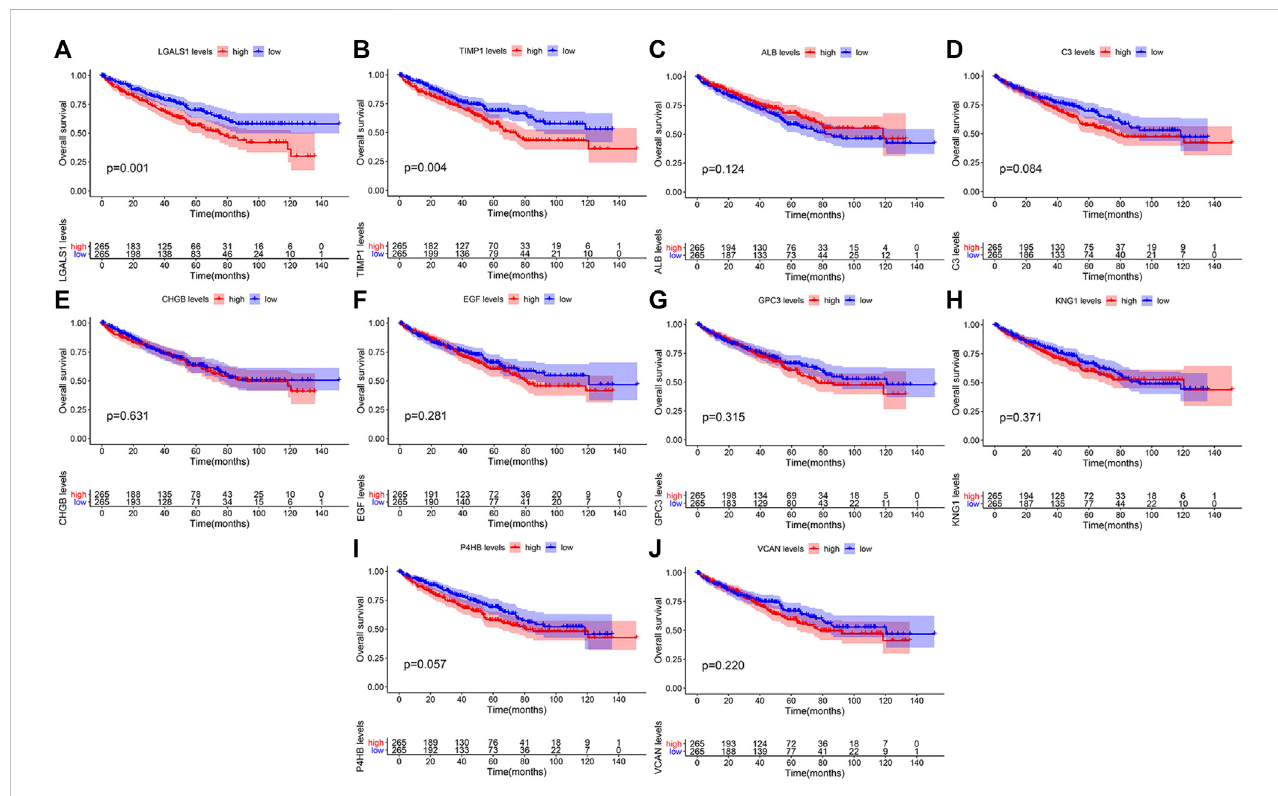
FIGURE 8 Overall survival (OS) of the ten hub genes in patients with ccRCC according to the Kaplan-Meier survival analysis. The patients were divided into high- expressionandlow-expressiongroupsbasedonthemedianexpression. (A) SurvivalanalysisforLGALS1inccRCC. (B) Survivalanalysis forTIMP1inccRCC. (C) Survival analysis for ALB in ccRCC. (D) Survival analysis for C3 in ccRCC. (E) Survival analysis for CHGB in ccRCC. (F) Survival analysis for EGF in ccRCC. (G) Survival analysis for GPC3 in ccRCC. (H) Survival analysis for KNG1 in ccRCC. (I) Survival analysis for P4HB in ccRCC. (J) Survival analysis for VCNA in